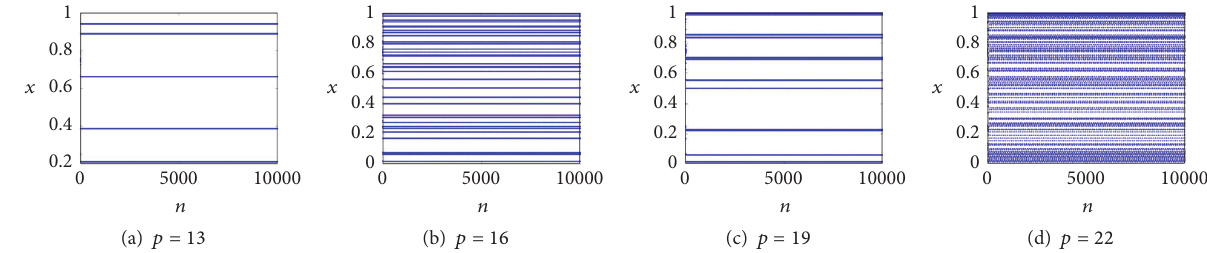
Figure 12: Time series of 𝑓 3 (𝑥) at 𝜆 = 3.984375 starting at 𝑥 0 = 0.25 and various precisions.